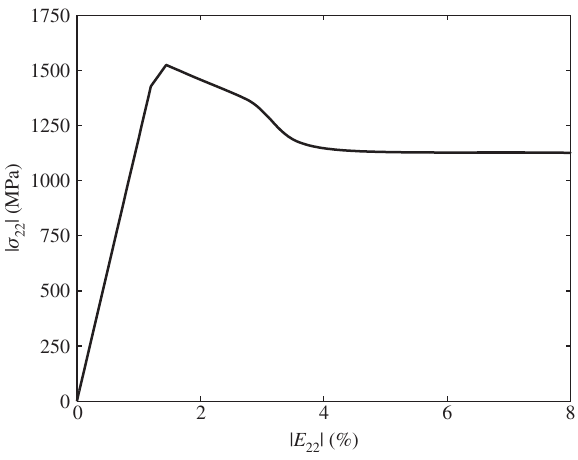
Figure 3 Sample S , general model behavior: average stress com- 1 ponent | σ | over applied strain | E | under compressive 22 22